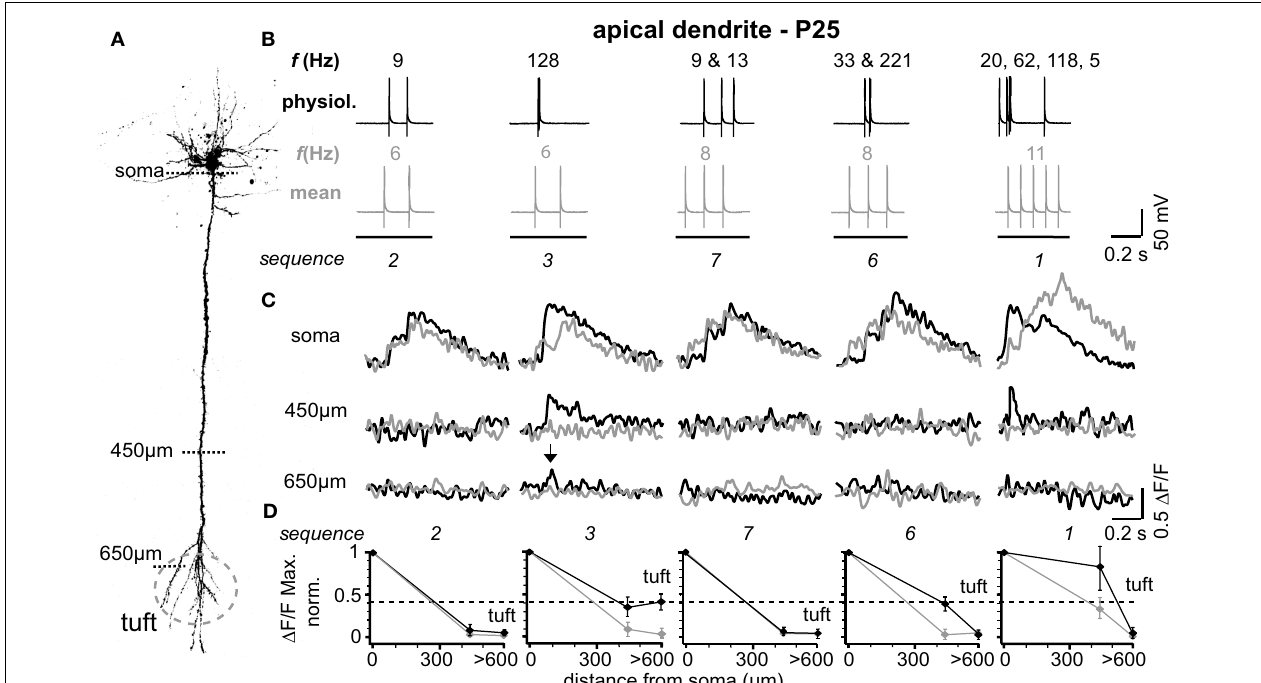
FIGURE 1 | Physiological fi ring patterns back-propagate more effi ciently into the apical arbor than mean fi ring patterns. (A) Two-photon fl uorescence image of a layer 5A pyramidal neuron showing the positions of the line-scan Ca 2 + measurements. (B) Five (out of ten tested) different physiological fi ring patterns (black traces) and the corresponding mean fi ring patterns (gray traces) triggered in a L5A pyramidal neuron at P25. Frequencies within the AP trains are given above the traces. (C) Ca 2 + transients were measured at the soma, 450 µm from soma, and 650 µm from soma (tuft region) (schematic). Note that only AP sequence 3 back-propagated into the